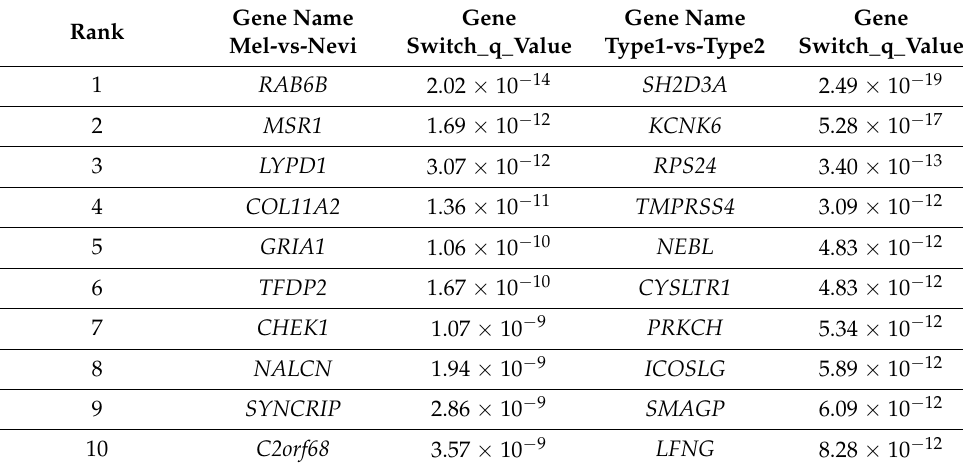
Table 1. IF switches between top 10 switched isoforms for two comparison